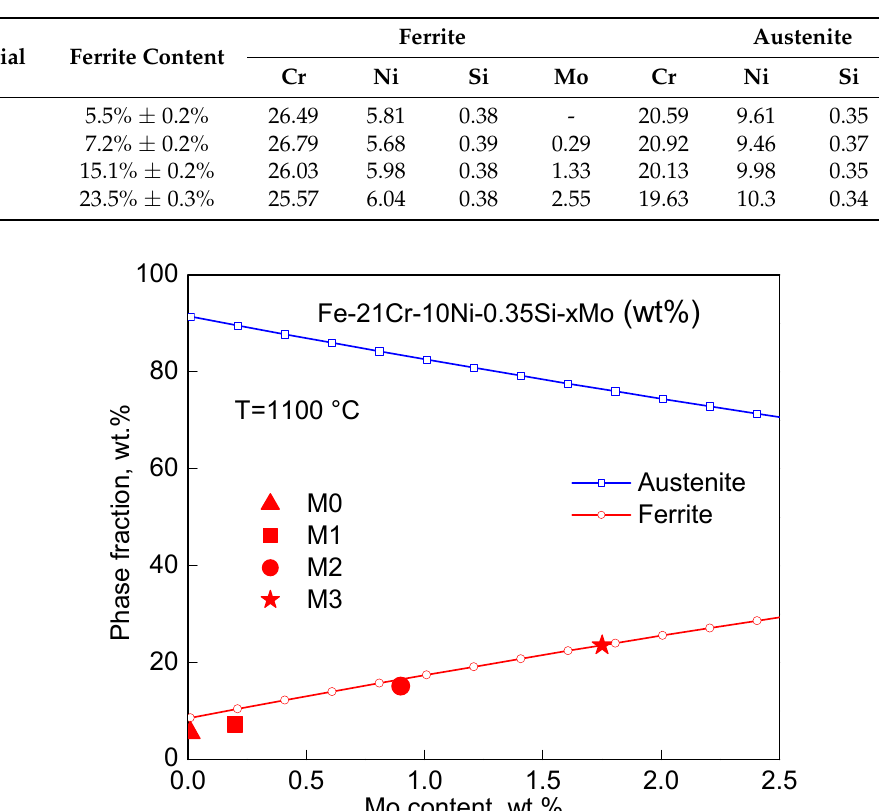
Figure 2. Variation of phase fraction with Mo content for Fe-21Cr-10Ni-0.35Si-xMo alloy, calculated using JMatPro. Table 1. The ferrite content and compositions in the two phases of CDSS.